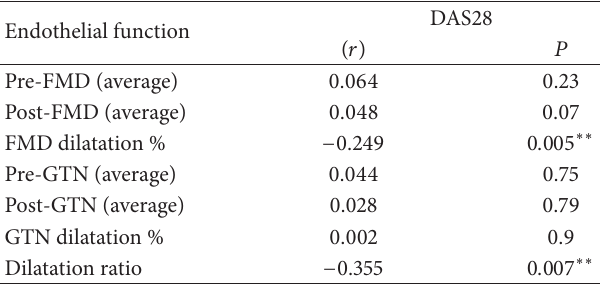
Table 15: Correlation between DAS28 and endothelial function in RA patients.